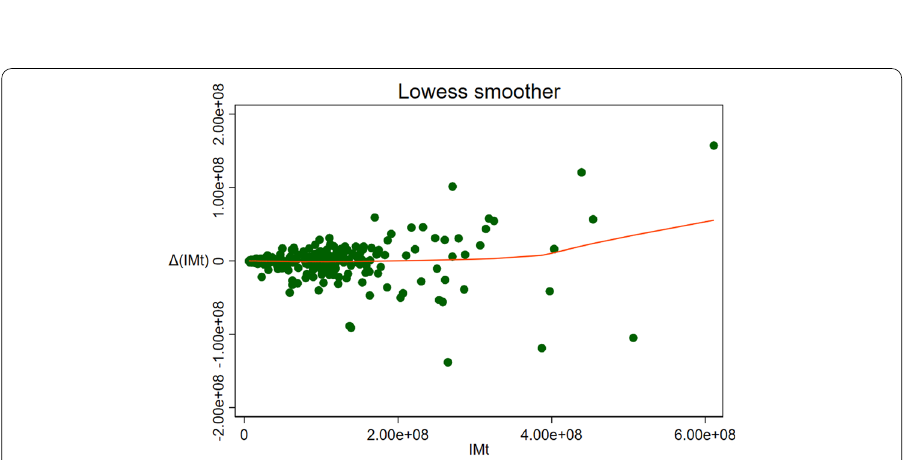
Fig. 4 Lowess smoother graph regressing market capitalization divided by the number of cryptocurrencies traded IM t on its change �( IM t ) . Source : Own